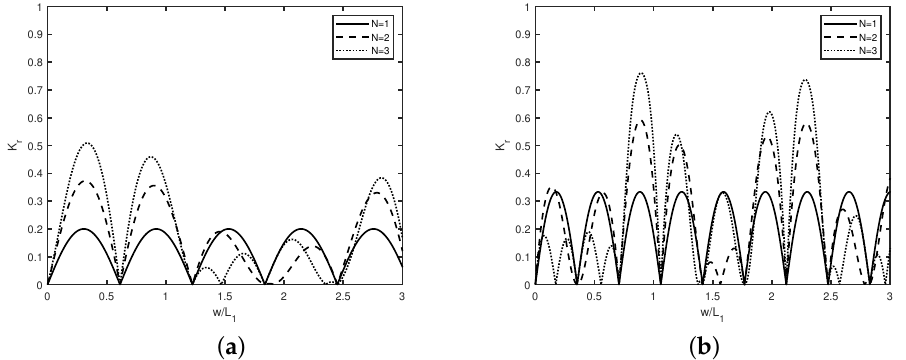
Figure 4. Reflection coefficient K r versus width w / L 1 for different number N of rectangular ( a ) trenches; ( b ) breakwaters in the absence of semi-infinite ice sheet with gap d / L 1 = 0.6, L 1 = 40 π m.